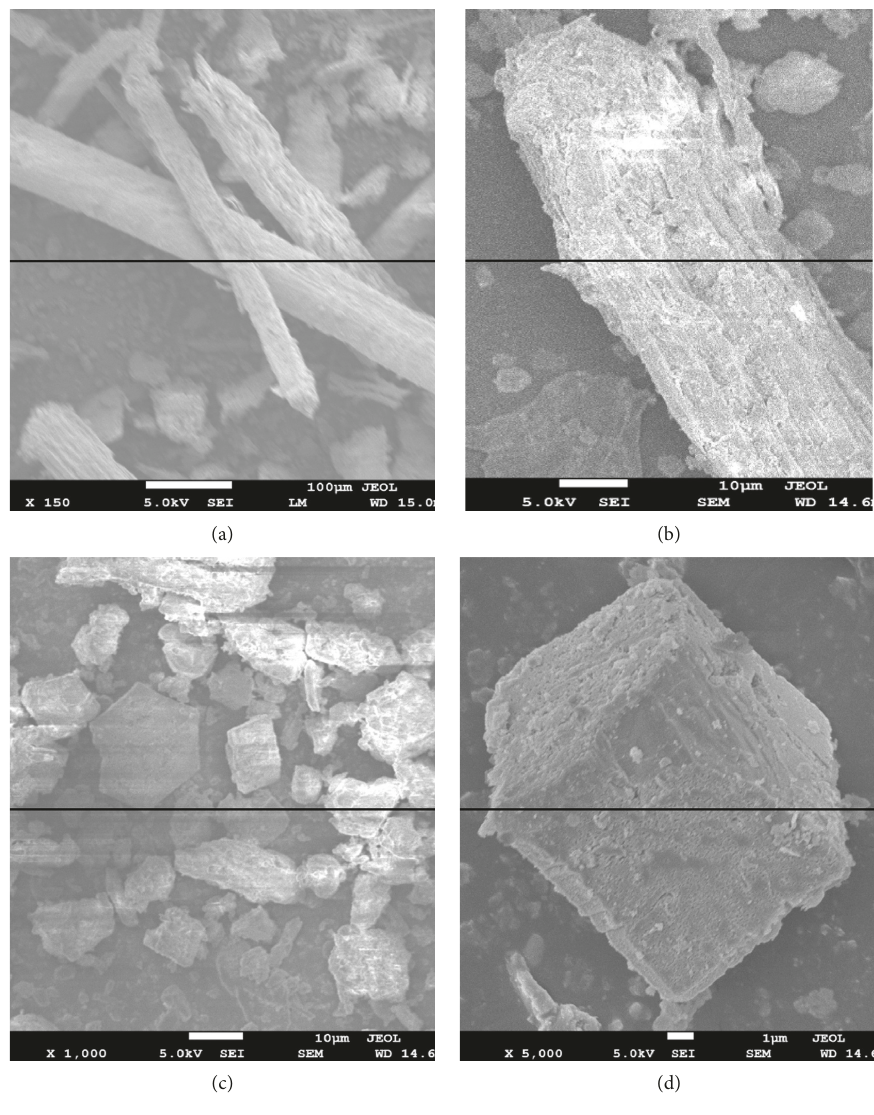
Figure 1: SEM of KRH 0.5 and KRS 0.5. Table 1: Parameters of pore structure of the